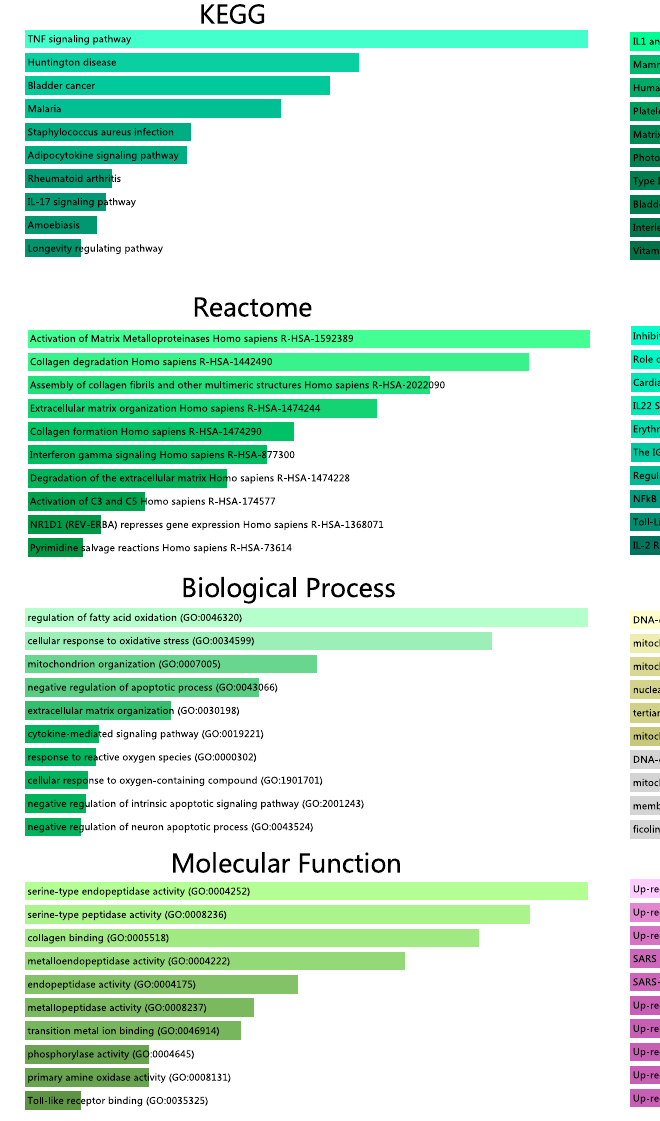
FIGURE 5 | Pathway enrichment analysis from KEGG, WikiPathways, Reactome and BioCarta databases. GO terms enrichment analysis including biological process, molecular function and cellular component aspects. All the results along with COVID-19 related gene sets were identi fi ed through the p value.